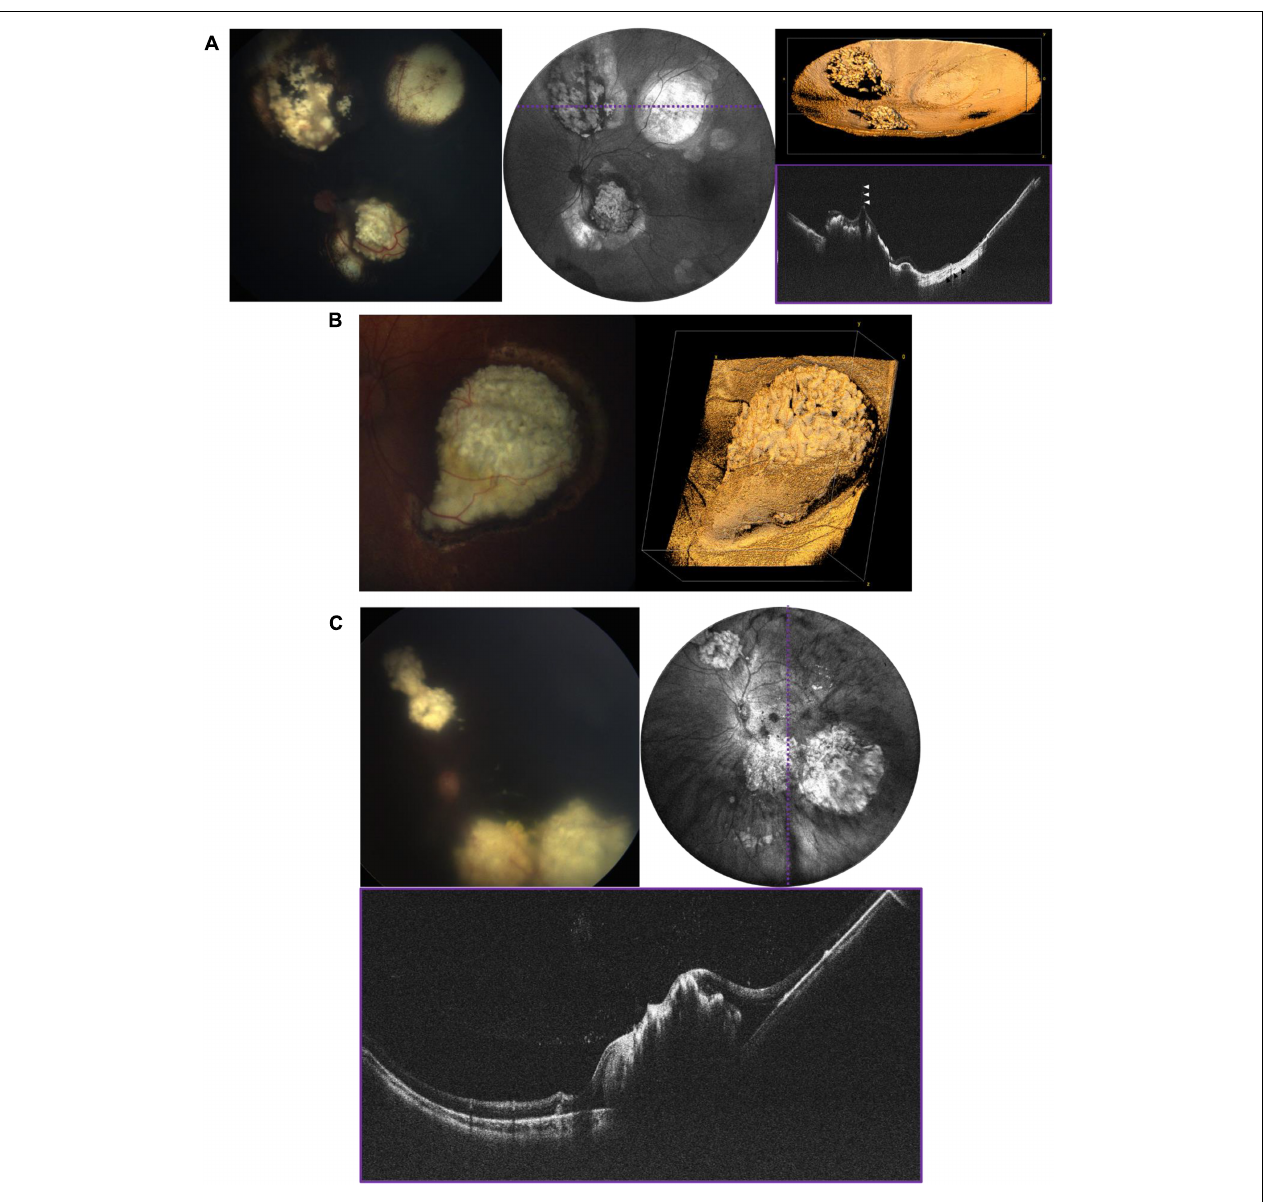
FIGURE 6 | Retinoblastoma evaluated with OCT in three patients with bilateral disease. (A) 3-year-old with multifocal RB in the left eye who has completed therapy. Left image is the fundus photograph, middle image is the 105 ◦ FOV OCT en face projection showing multiple regressed tumors, with dashed purple line corresponding to the location of the B-scan on the bottom right. White arrows point toward a vitreous band, while black arrows point to an area of retinal atrophy. Top right image shows three-dimensional rendering of the same volume shown in the middle panel. (B) Large partially calcified retinoblastoma in a 5-month-old patient undergoing systemic chemotherapy. Fundus photograph is shown on the left, and three-dimensional rendering of 40 ◦ FOV, high-resolution OCT volume is shown on the right. (C) 7-month-old undergoing systemic chemotherapy with active RB including diffuse vitreous seeding and multifocal tumors in the left eye. Top left image shows the fundus photograph, top right shows the 105 ◦ FOV OCT en face projection, with dashed purple line corresponding to the B-scan